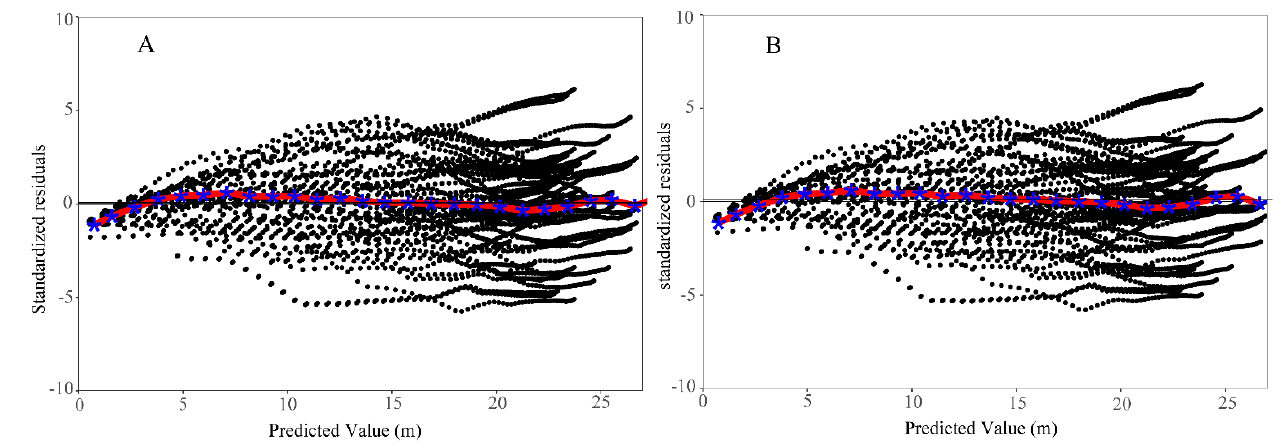
Figure 4. Distribution of the residuals for the model fitting data (predicted – measured) on dominant height growth prediction. ( A ) NLME7, ( B ) NLME8. The mean residuals (* solid line) were calculated for one-meter site index classes.